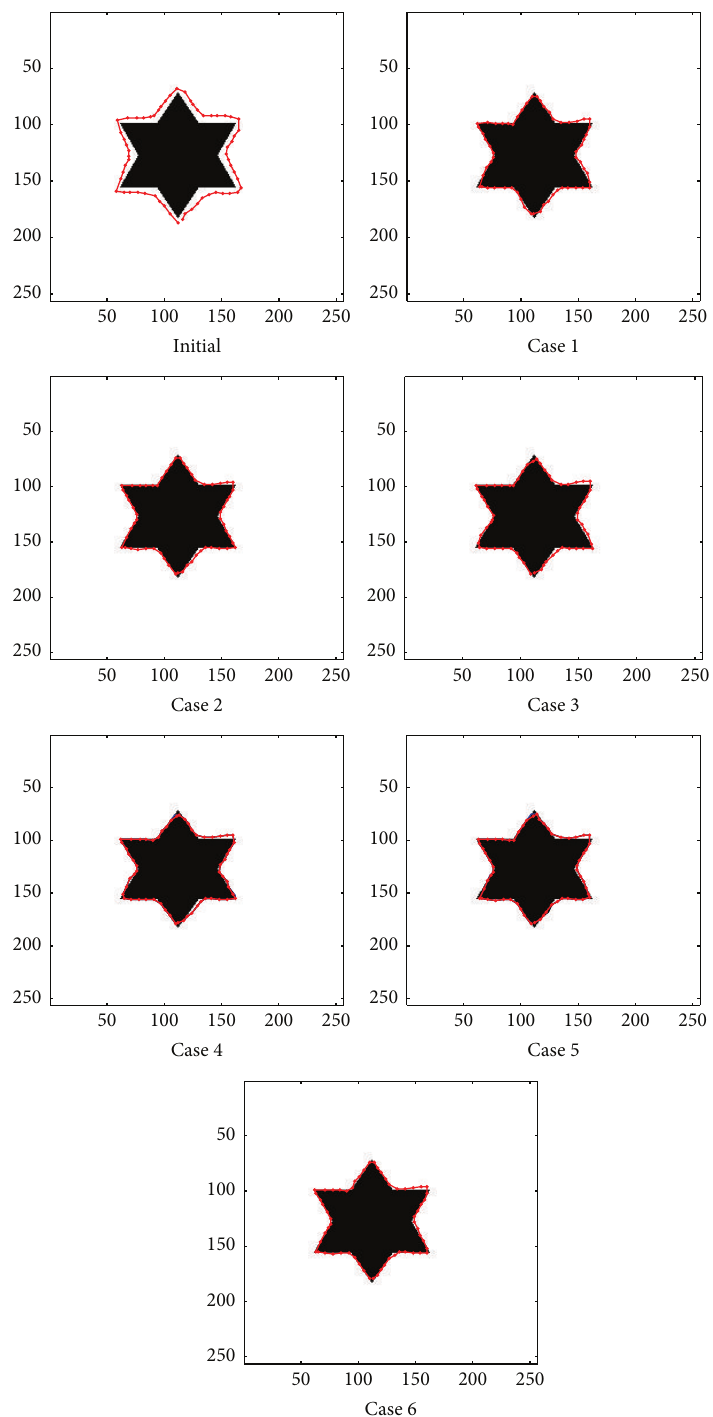
Figure 16: Active contour model implementation by “proposed multiswarm PSO” method for different cases of inertia. Results for “Star” image with control points = 60, 𝛼 = 0.05 , 𝛽 = 0.025 , and Γ = 0.16